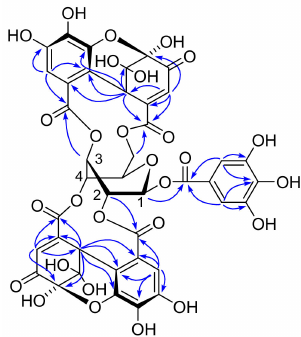
Figure 4. Selected HMBC correlations of major component of 3